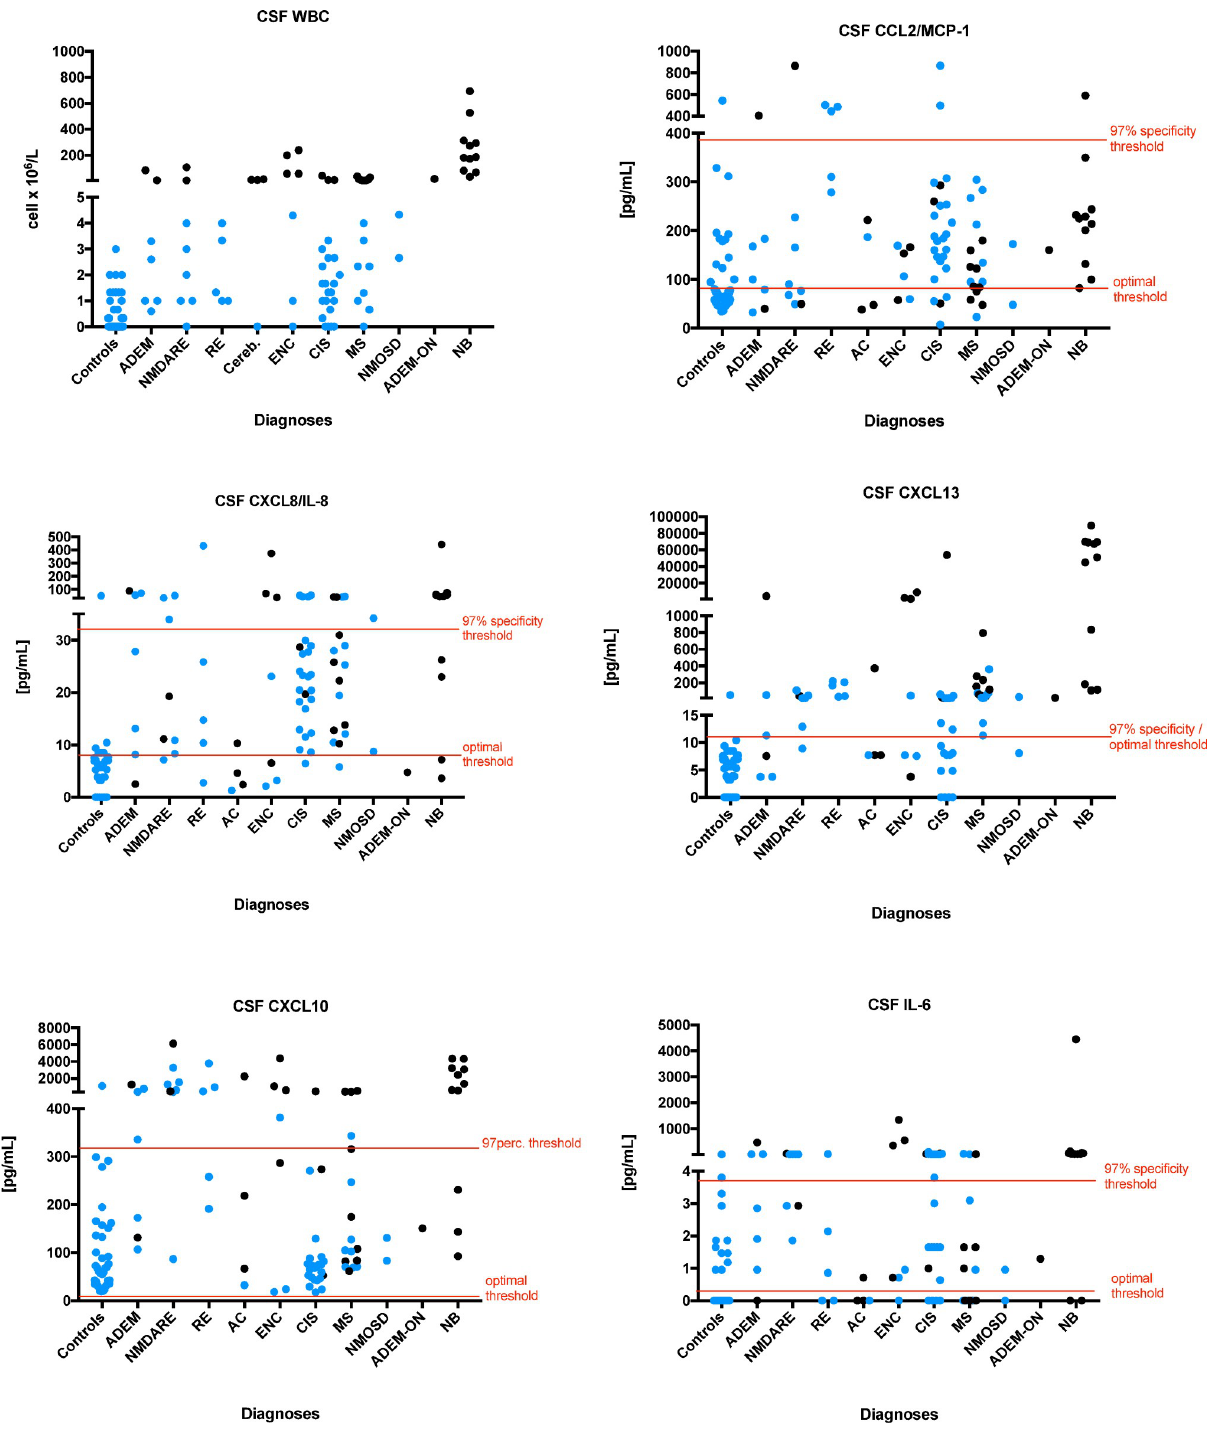
Fig 3. Pleocytosis and chemo/cytokine levels in the CSF according to the diagnosis. The blue dots indicate samples from patients without CSF pleocytosis ( < 5 cells/ μ L). The lines in graphs of CSF chemo/cytokine levels indicate values of 1) optimal thresholds determined by ROC analyses using all symptomatic inflammatory samples and controls and 2) 97% specificity thresholds derived from ROC curves using only symptomatic inflammatory samples without pleocytosis and controls. The optimal and 97% specificity thresholds are identical for CXCL13.